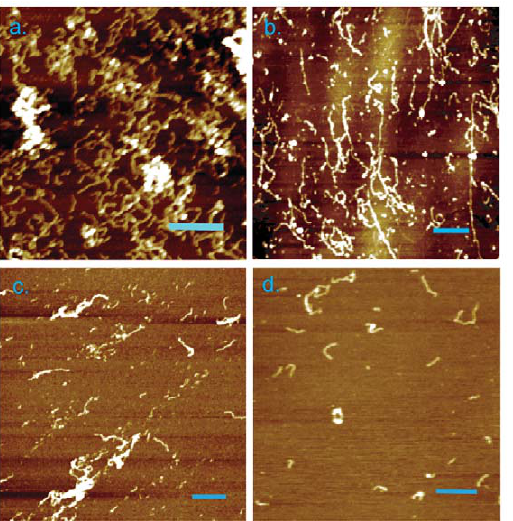
Figure 1. AFM images of freshly dissolved A b 1–40 peptide (0.2 mM) and S100A9 protein (0.02 mM) mixture, incubated at pH 7.4 and 37 0 C for (a) 1 d; and (b) 3 d. S100A9 (0.2 mM) with (c) A b 1– 40 (0.1 mM) ; (d) A b 1–40 (0.02 mM) incubated at pH 7.4 and 37 0 C for 3 d. The scale bars denote 1000 nm for Fig. (a), 1200 nm for (b), 600 nm for (c) and 600 nm for (d).